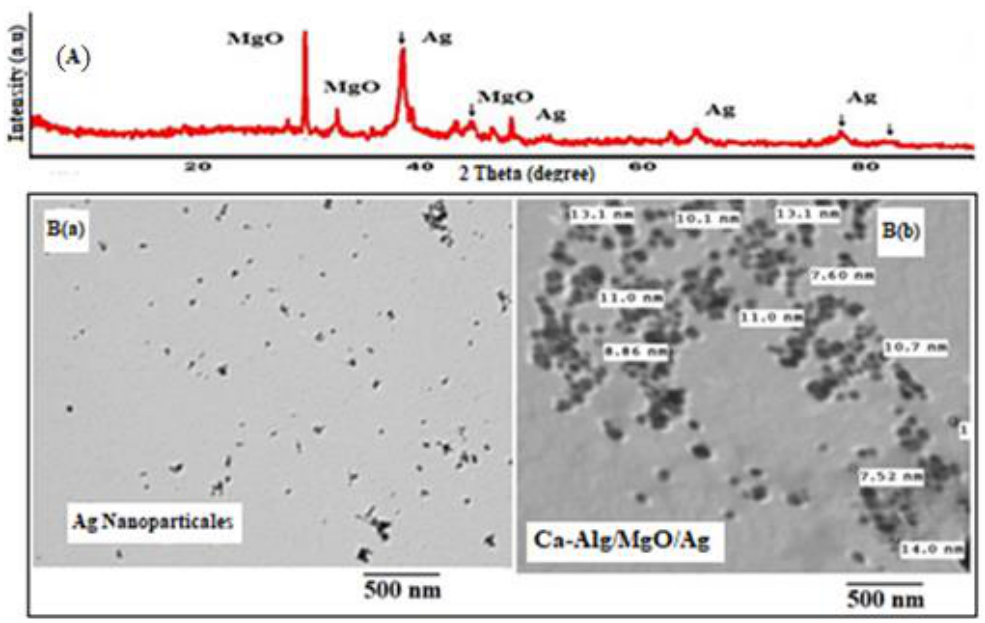
Figure 2. ( A ) XRD pattern of Ca-ALG/MgO/Ag nanocomposite beads, ( B ( a )) TEM image of Ag na- noparticles, and ( B ( b )) TEM image of Ca-ALG/MgO/Ag nanocomposite